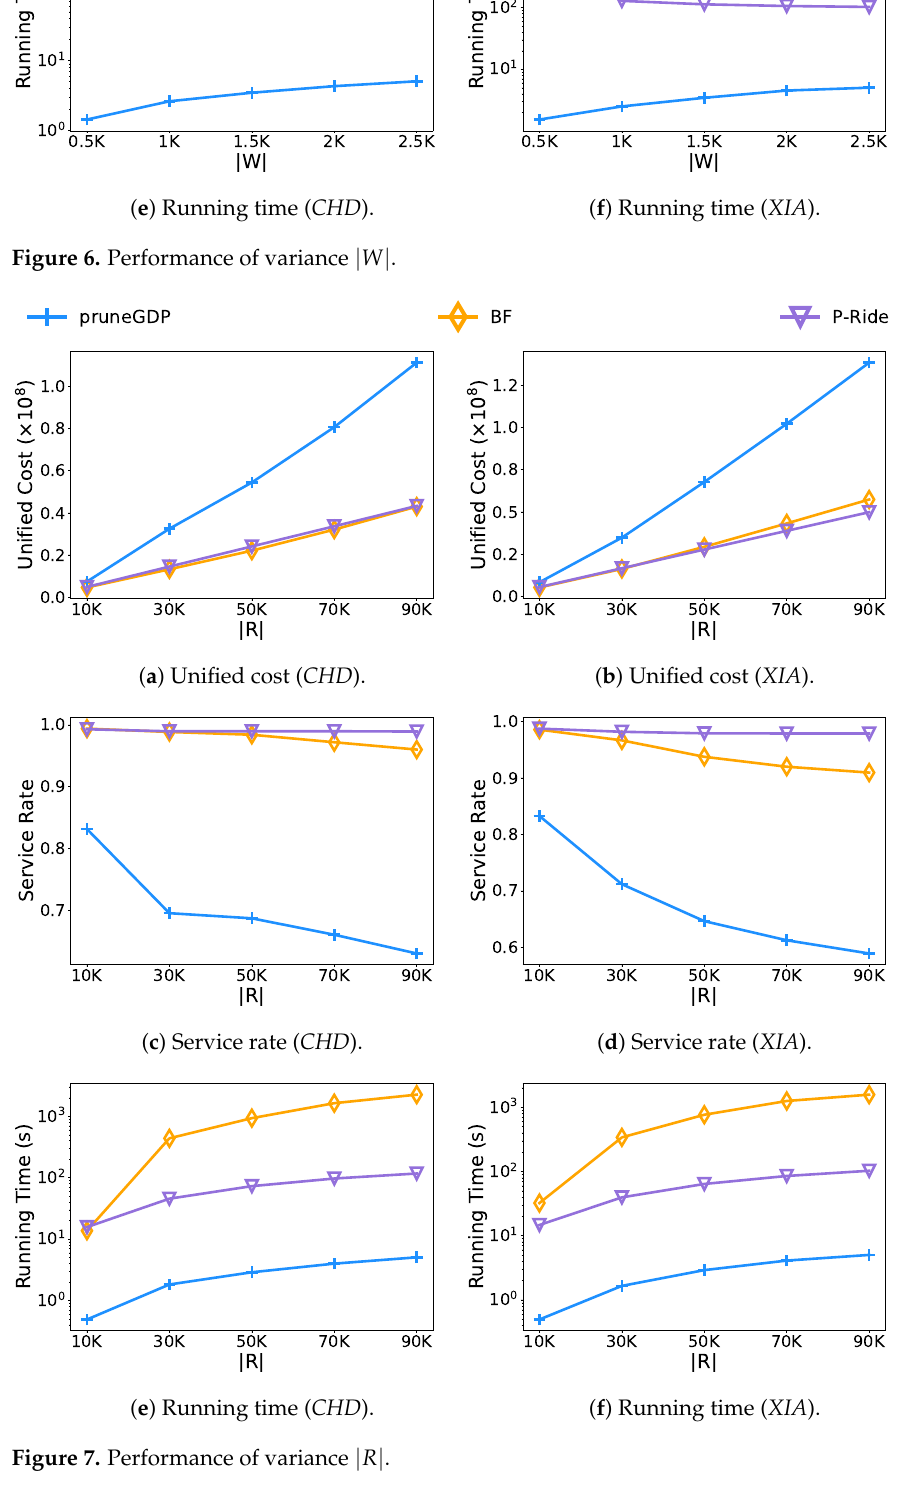
Figure 7. Performance of variance | R |